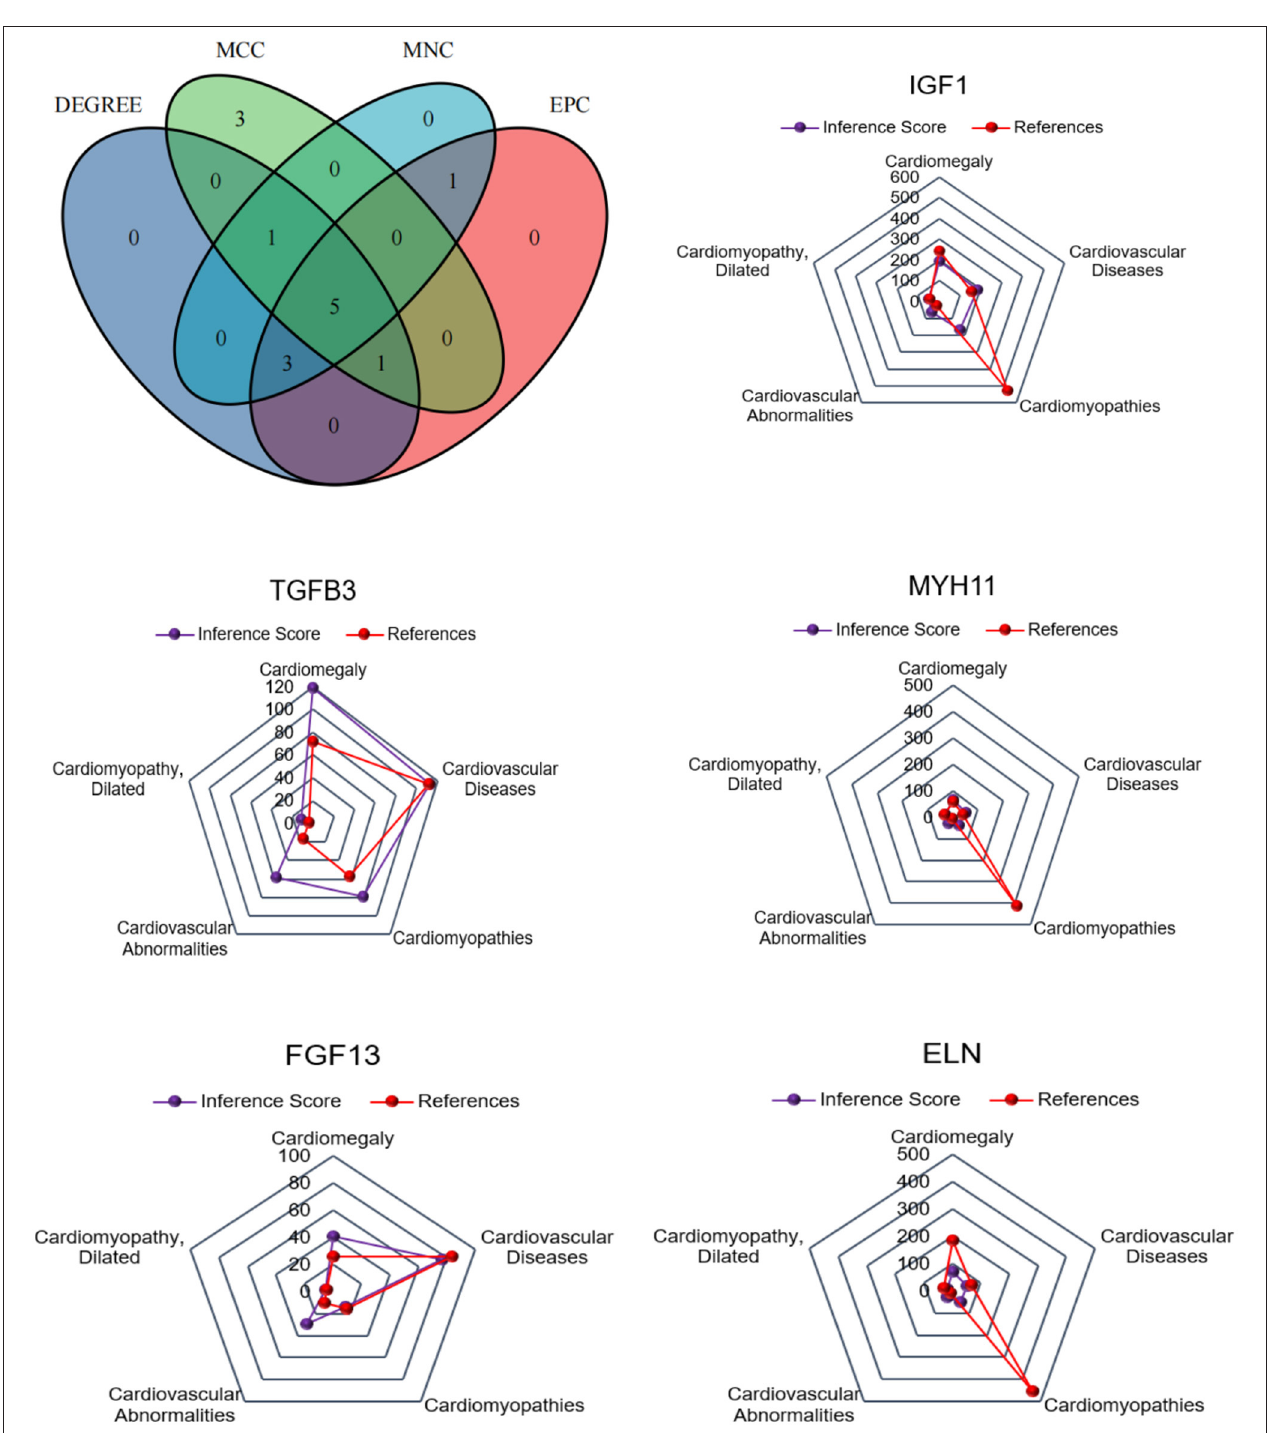
FIGURE 7 | The common hub genes identified from degree, edge percolated component (EPC), maximal clique centrality algorithm (MCC), and maximum neighborhood component (MNC) in CPI vs. CFs. IGF1, MYH11, TGF β 3, FGF13, and ELN were identified as related to cardiovascular disease based on the CTD